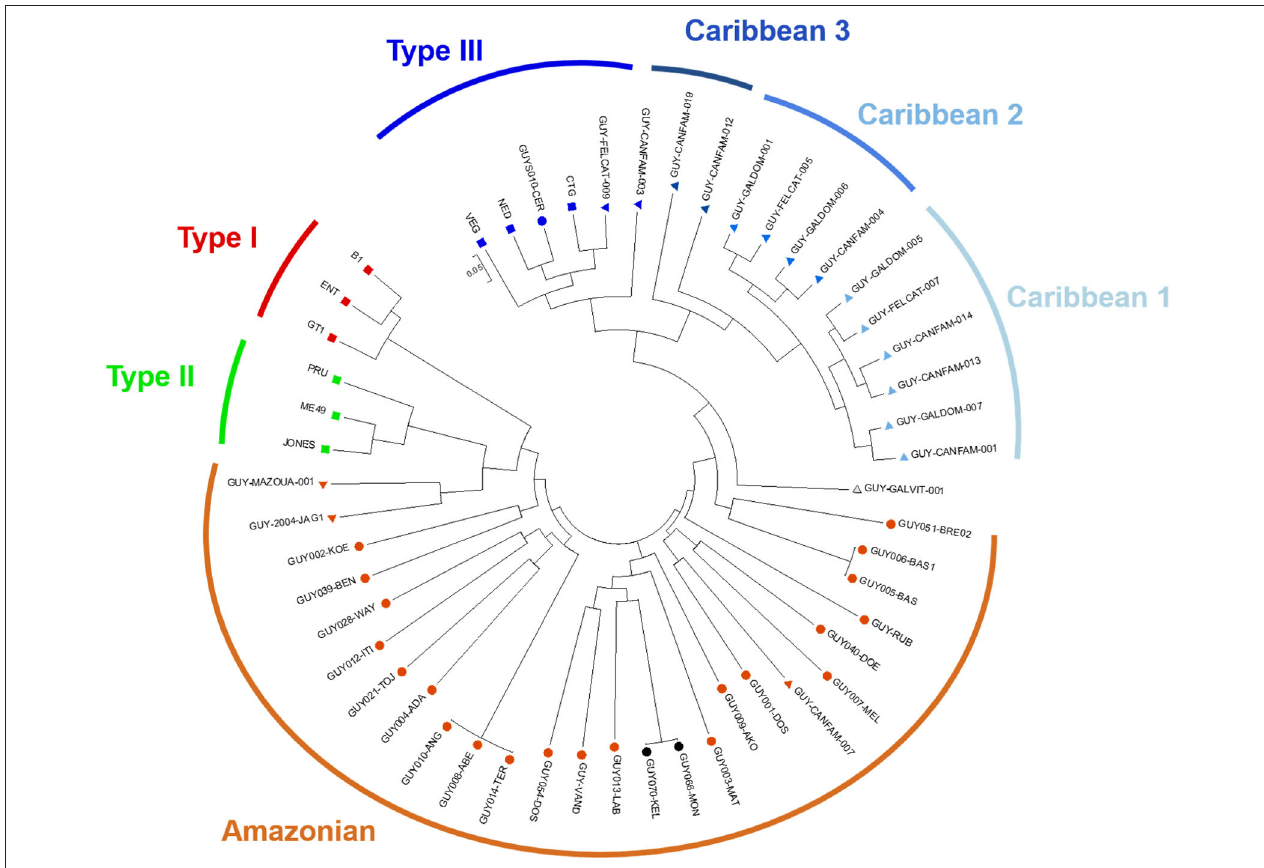
FIGURE 3 | Neighbor-joining clustering of T. gondii strains from French Guiana, based on 15 microsatellite markers: circles and triangles correspond, respectively to strains of human and animal origin; black circles correspond to the 2 strains isolated during the Camopi outbreak with 15/15 markers amplified; red, green, and dark blue squares are reference strains of Type I, Type II, and Type III genotype,